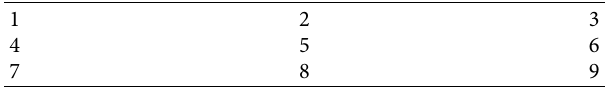
Table 4: Artifcial observations to show the impact of an outlier.